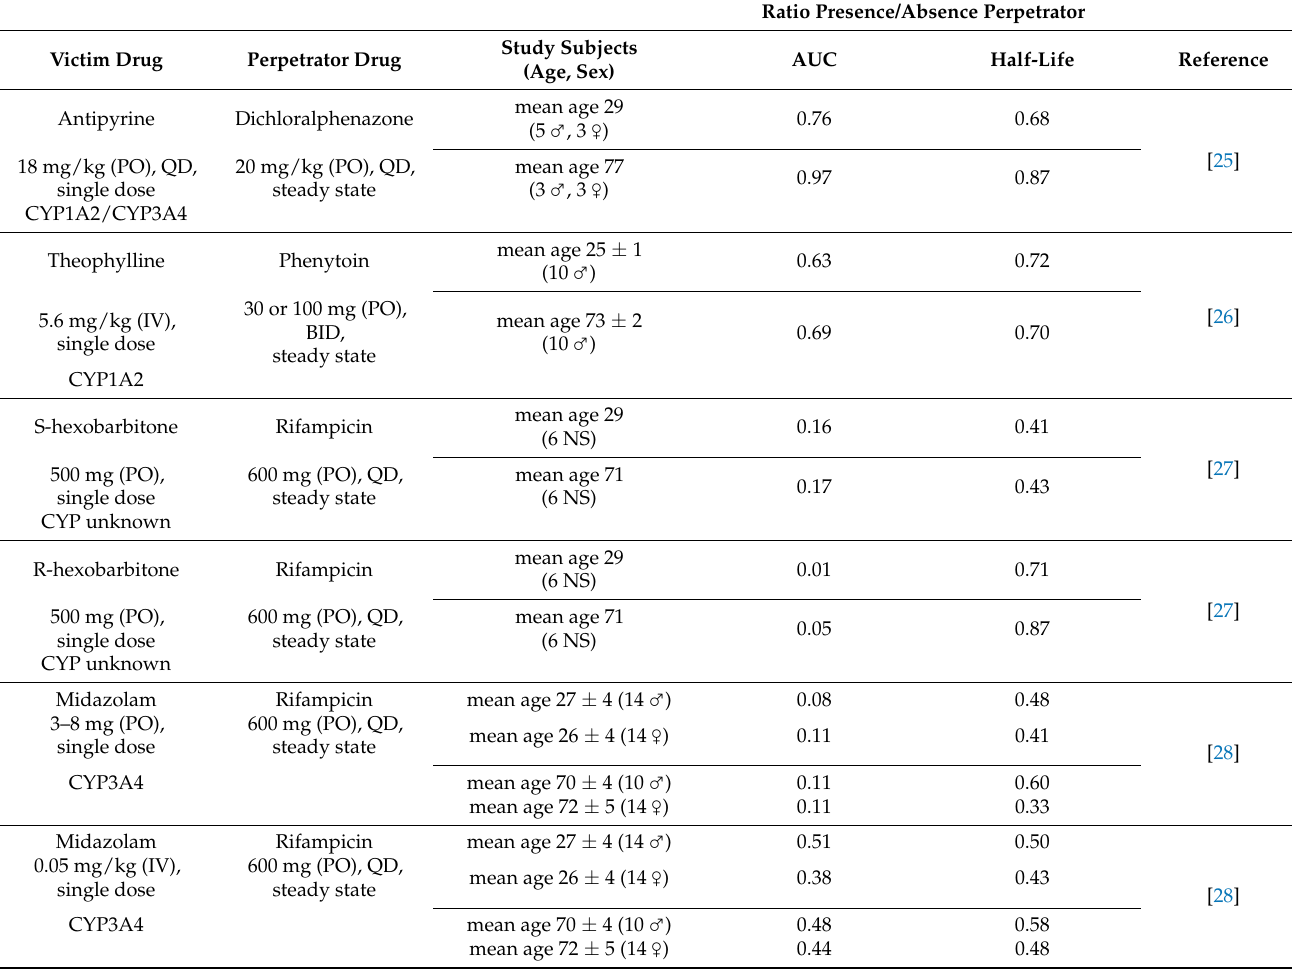
Table 3. Comparison of DDI magnitudes with inducers impacting drug metabolism in elderly individuals relative to young individuals.